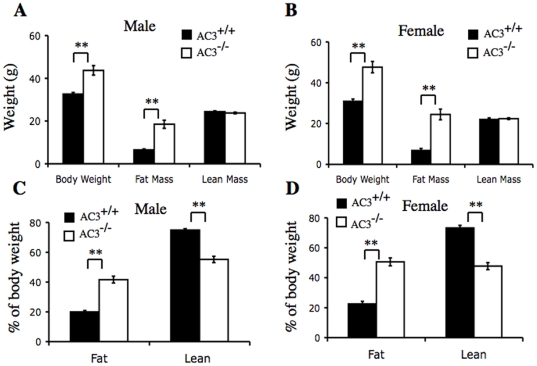
AC3−/− mice weight gain is due to an increase in fat mass.The body compositions of AC3+/+ and AC3−/− mice were determined in conscious mice by quantitative magnetic resonance (QMR). (A) Body composition of male AC3+/+ and AC3−/− mice at 10 months. (B) Body composition of female AC3+/+ and AC3−/− mice at 10 months. (C) Percentage of fat mass and lean mass of male AC3+/+ and AC3−/− mice at 10 months. (D) Percentage of fat mass and lean mass of female AC3+/+ and AC3−/− mice at 10 months. N = 8 mice for each group. Data are represented as means±SEM. **, p<0.01.